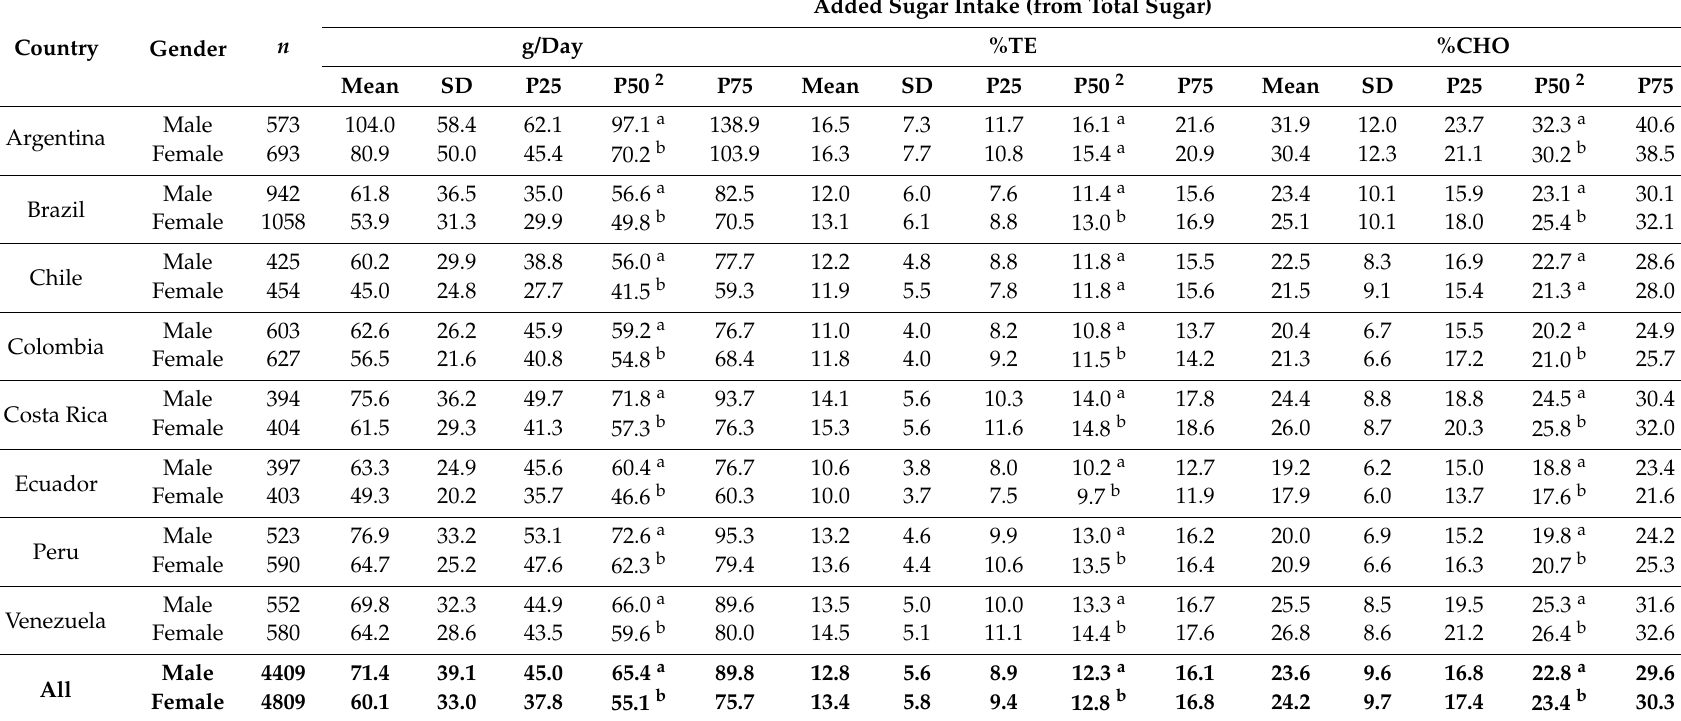
Table 4. Added sugar intakes 1 in individuals residing in urban areas of Latin American countries, according to gender; Latin American Health and Nutrition Study (ELANS),